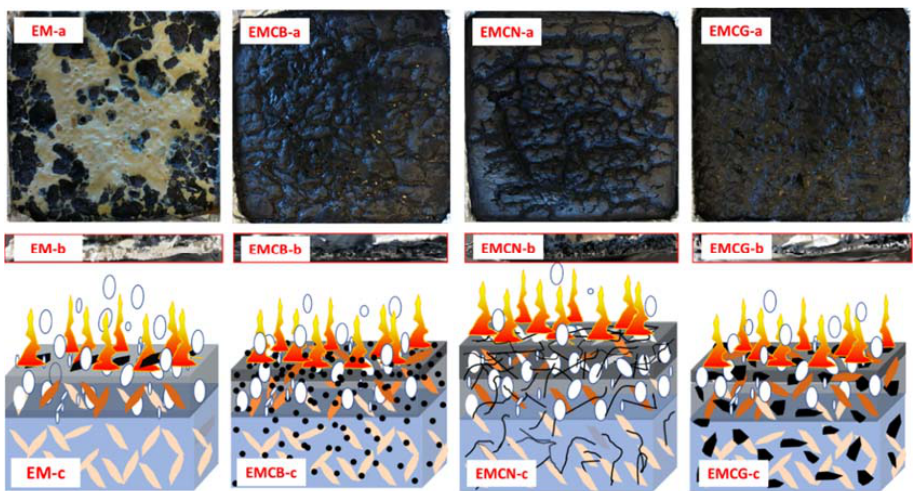
Figure 7. Cross-section pictures of residue obtained by interrupted irradiation and combustion diagram under cone calorimeter at 125 s. ( a ) upper surface; ( b ) cross-section; ( c ) combustion schematic diagram.